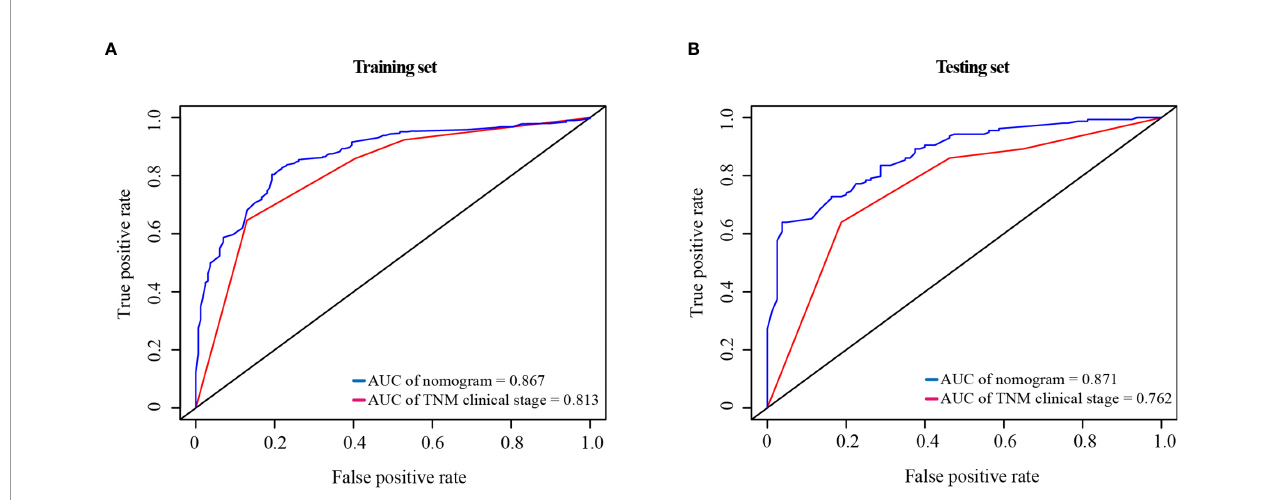
FIGURE 7 | ROC curve of the nomogram and the TNM clinical stage in the training set (A) and testing set (B) . AUC, area under the curve; ROC, receiver operating characteristic; TNM clinical stage, tumor – node – metastasis clinical